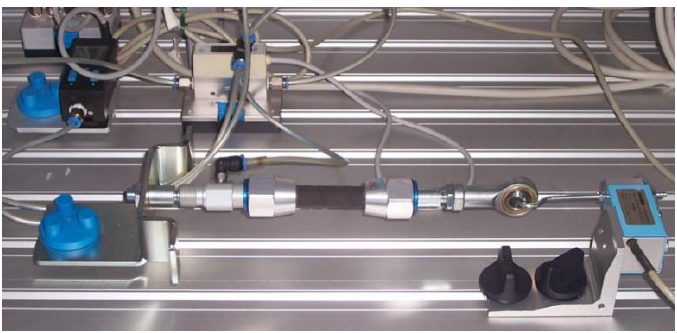
Figure 10. Measuring the forces developed by the pneumatic muscle.